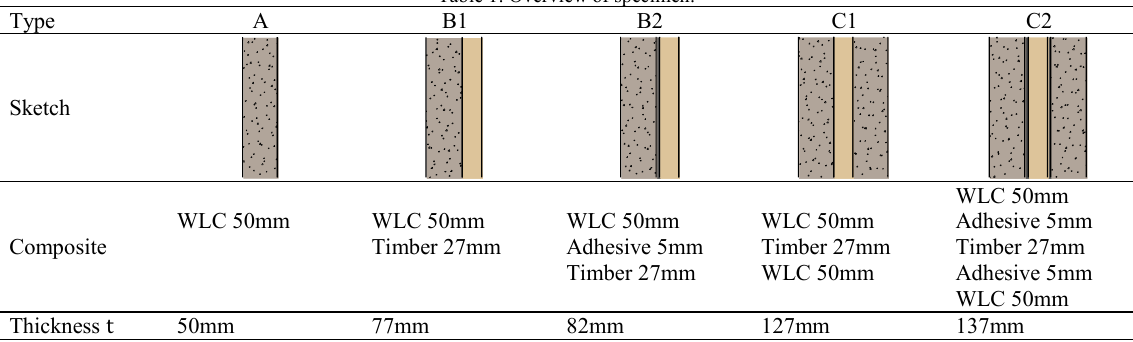
Table 1: Overview of specimen.